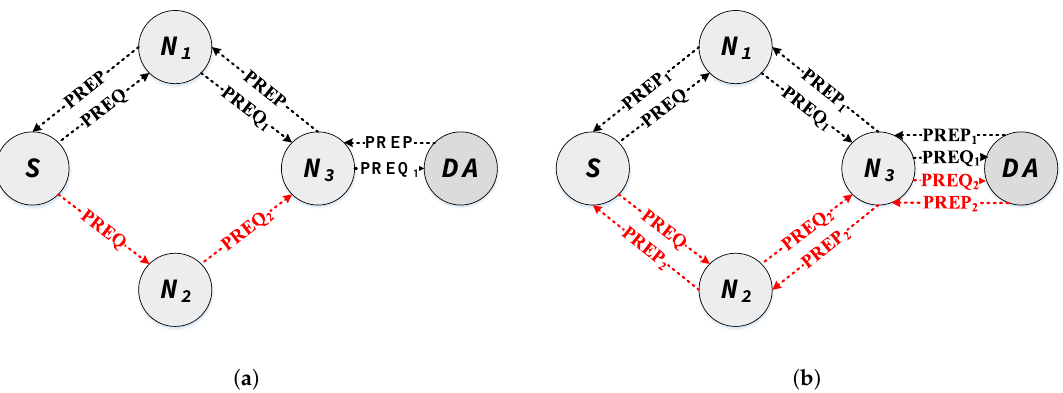
Figure 3. Modification to the acceptance criteria when the destination node receives a